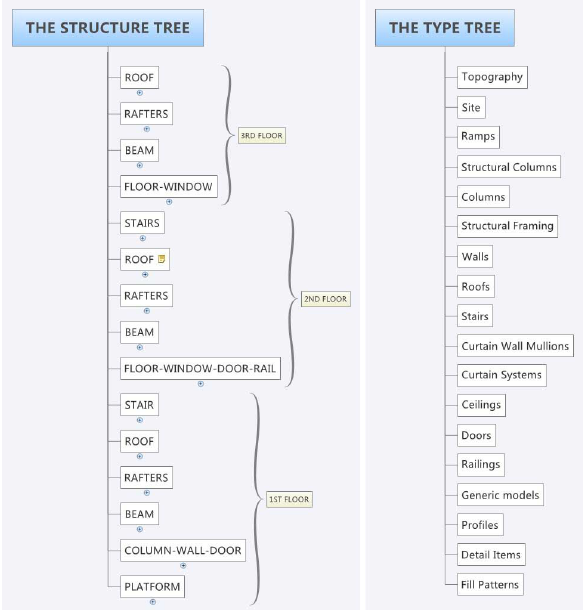
Figure 1. The structural tree and the type tree